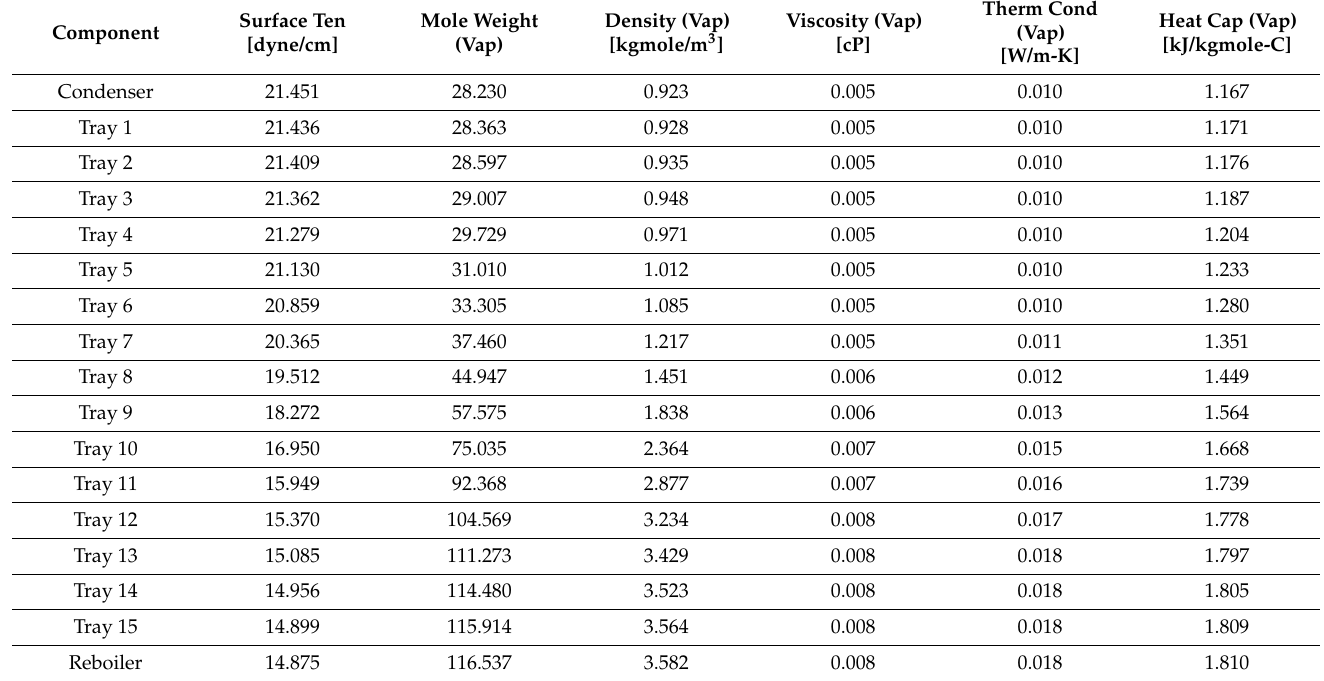
Table 10. Column properties vs. tray position from top for steam.